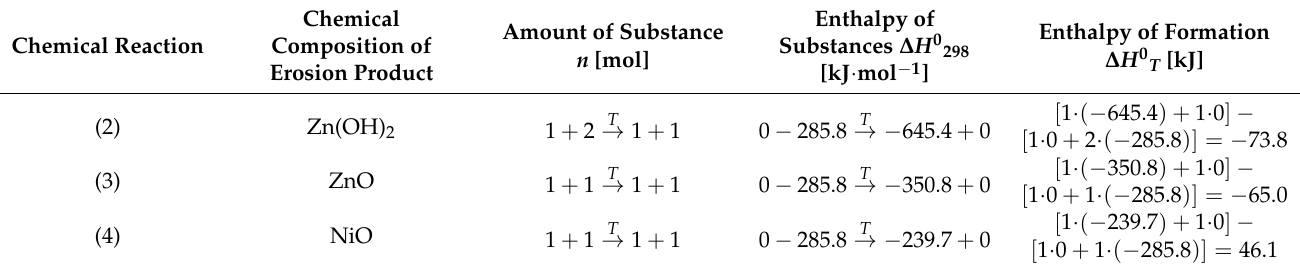
Table 8. Calculated enthalpy of formation of some Zn- and Ni-containing substances.